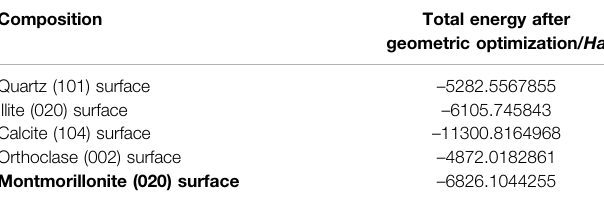
TABLE 1 | Calculation results for the total energy of different minerals after geometry optimization.